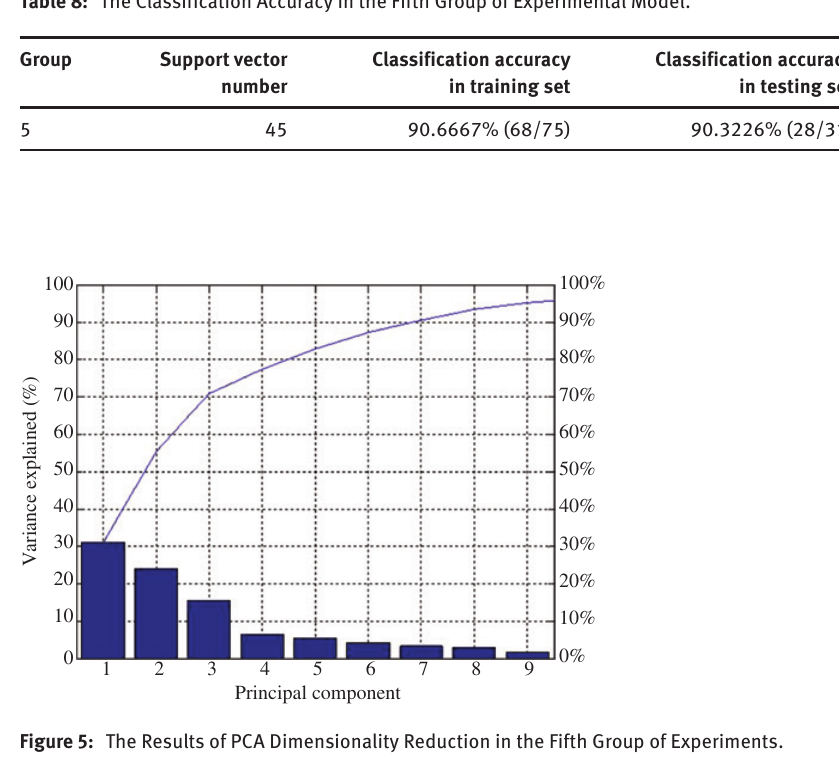
Table 8: The Classification Accuracy in the Fifth Group of Experimental Model.